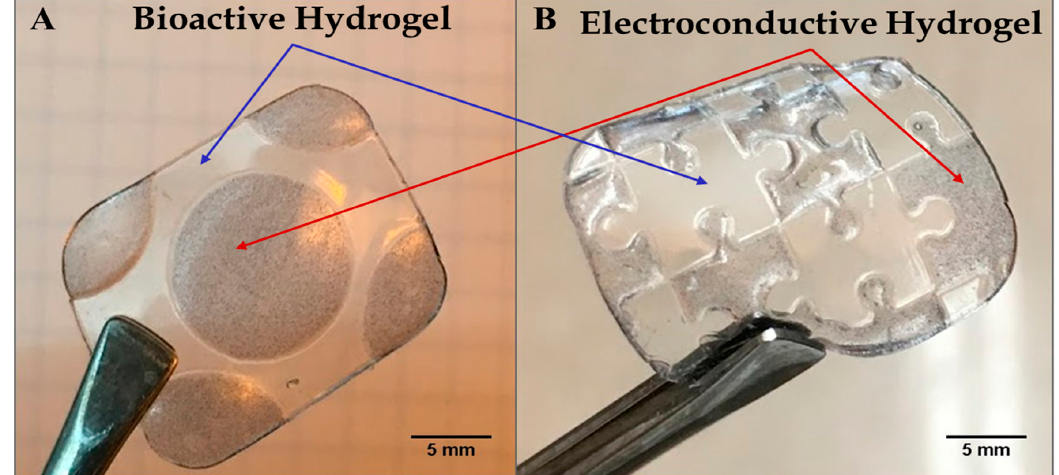
Figure 3. Microlithographic fabrication of hybrid constructs based on the use of photomasks to create complex structures of adjacent non-conductive p(HEMA- co -HMMA- co -PEGMA) hydrogels and electroconductive (1.00 wt% PAn-PAAMPSA) hydrogels. ( A ) Circular electroconductive hydrogel surrounded by non-conductive hydrogel and ( B ) puzzle-piece pattern of electroconductive and non-conductive, bioactive hydrogel.